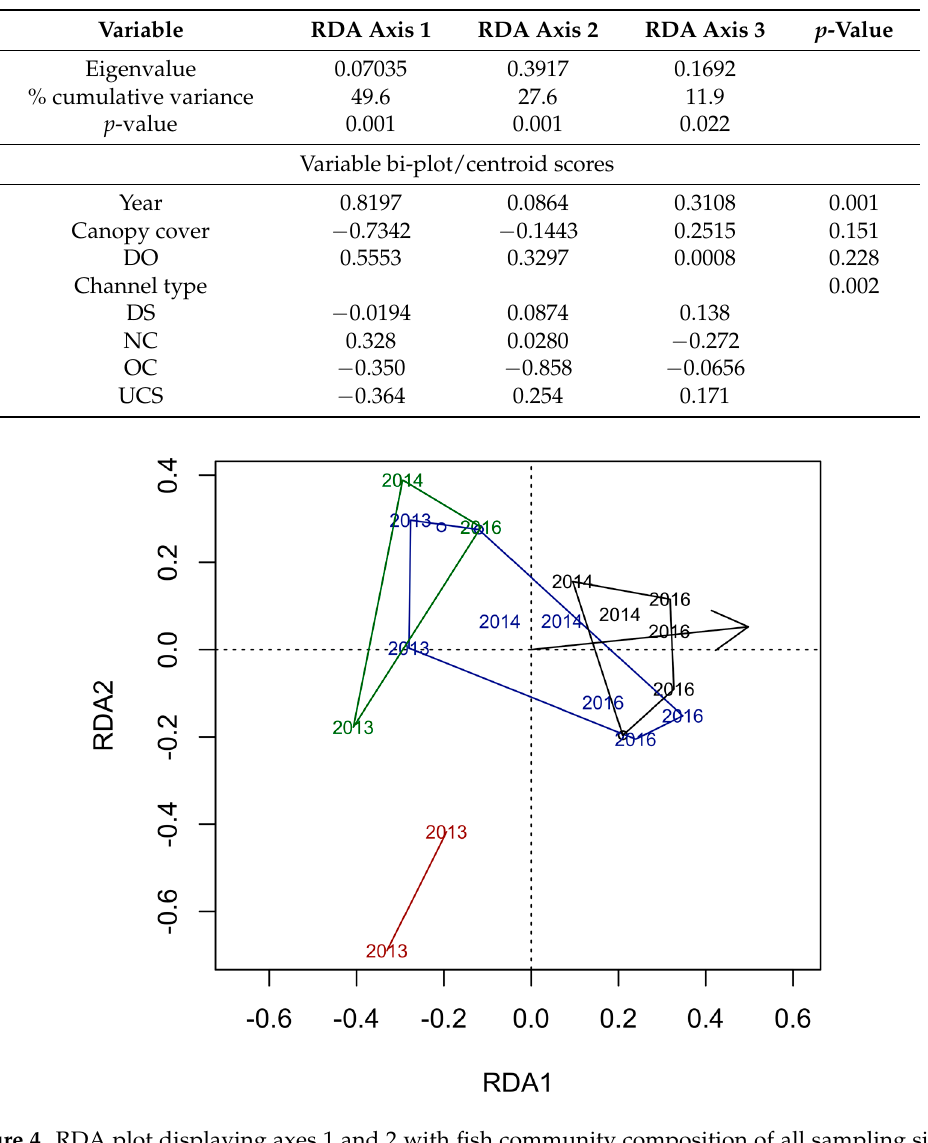
Figure 4. RDA plot displaying axes 1 and 2 with fish community composition of all sampling sites during each year constrained by canopy cover, DO, year, and channel type. Sample sites (labeled with year) are presented in ordination space according to Hellinger’s distance and are colored red for old channel, green for upstream control site, blue for downstream sites, and black for new channel sites. Polygons are drawn around the outermost site for each channel type, and a vector is drawn to indicate increasing values for year.